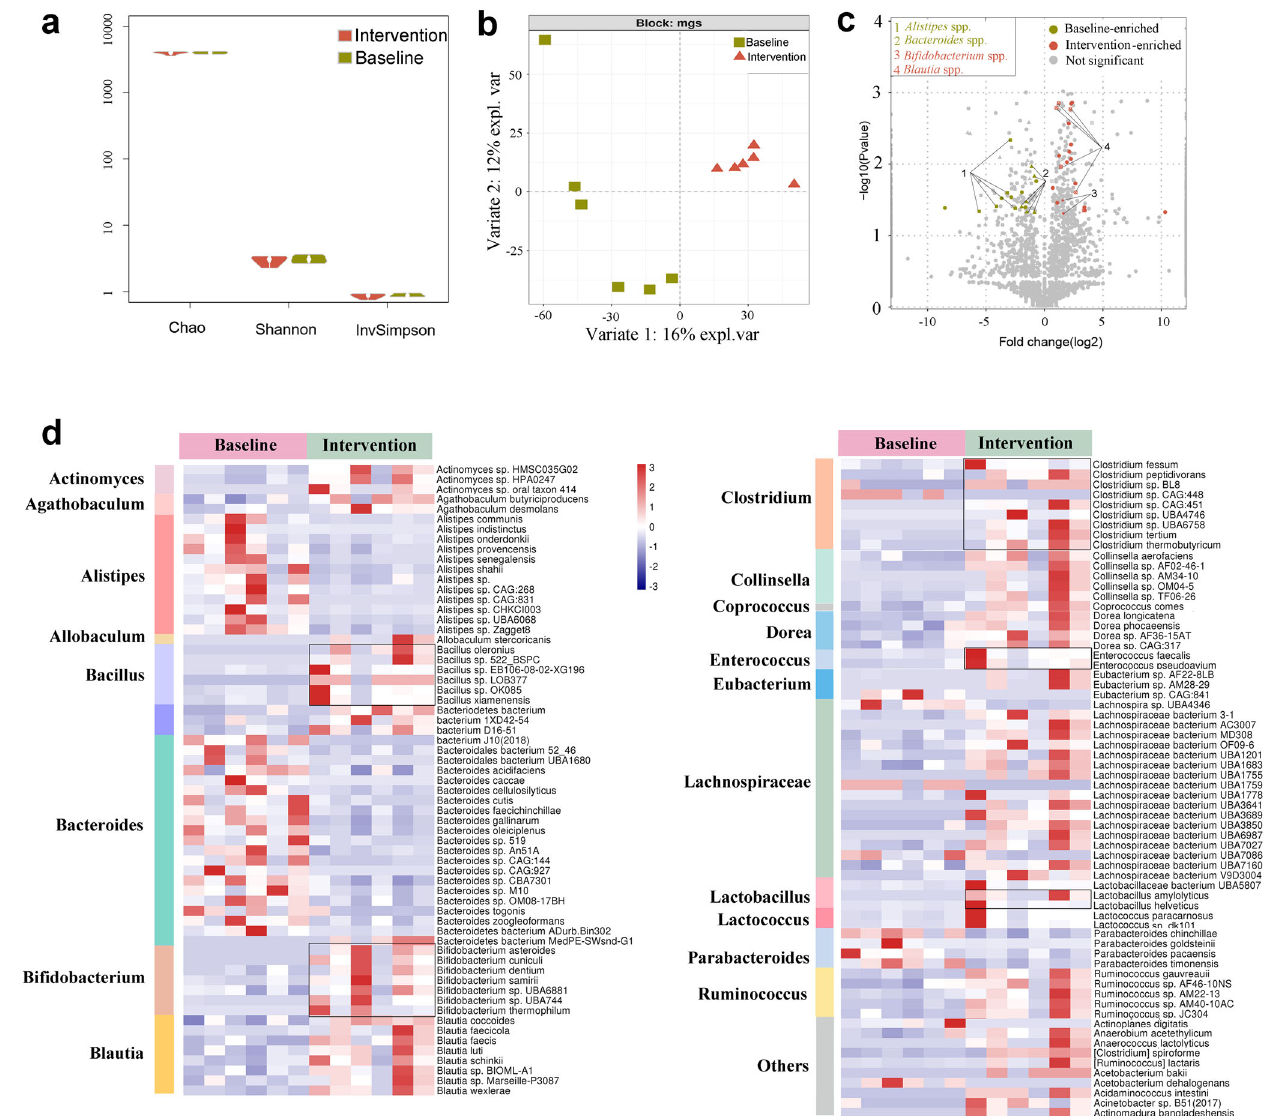
Fig. 3 Probiotic yogurt signi fi cantly altered the symbiosis of gut microbiota after 12 weeks of intervention. a No signi fi cant differences were noted in bacterial α -diversity values between the two groups. b Bacterial signatures between the two groups varied signi fi cantly (Bray – Curtis distance, PERMANOVA, p = 0.025), as shown using DIABLO. c Signatures of gut microbiota in the baseline and intervention groups. The x-axis shows the fold change of a species abundance of the two groups. The y-axis shows the − log10 ( p value) of each species in the two groups. Species with signi fi cant difference in abundance between the two groups are shown in green (baseline-enriched) and red (intervention-enriched); species belonging to the same genus are linked by lines. Species with no signi fi cant difference in abundance between the two groups are shown in gray. Metastats was used to determine MGS signatures. d The heatmap shows the prominent species that differed signi fi cantly in abundance between the baseline and intervention groups. Red indicates enrichment and blue decrease. The magnitude of the changes is proportional to the color intensity. n = 6 in each group. Wilcoxon rank-sum test was performed. Source data and exact p values are provided in the source data fi